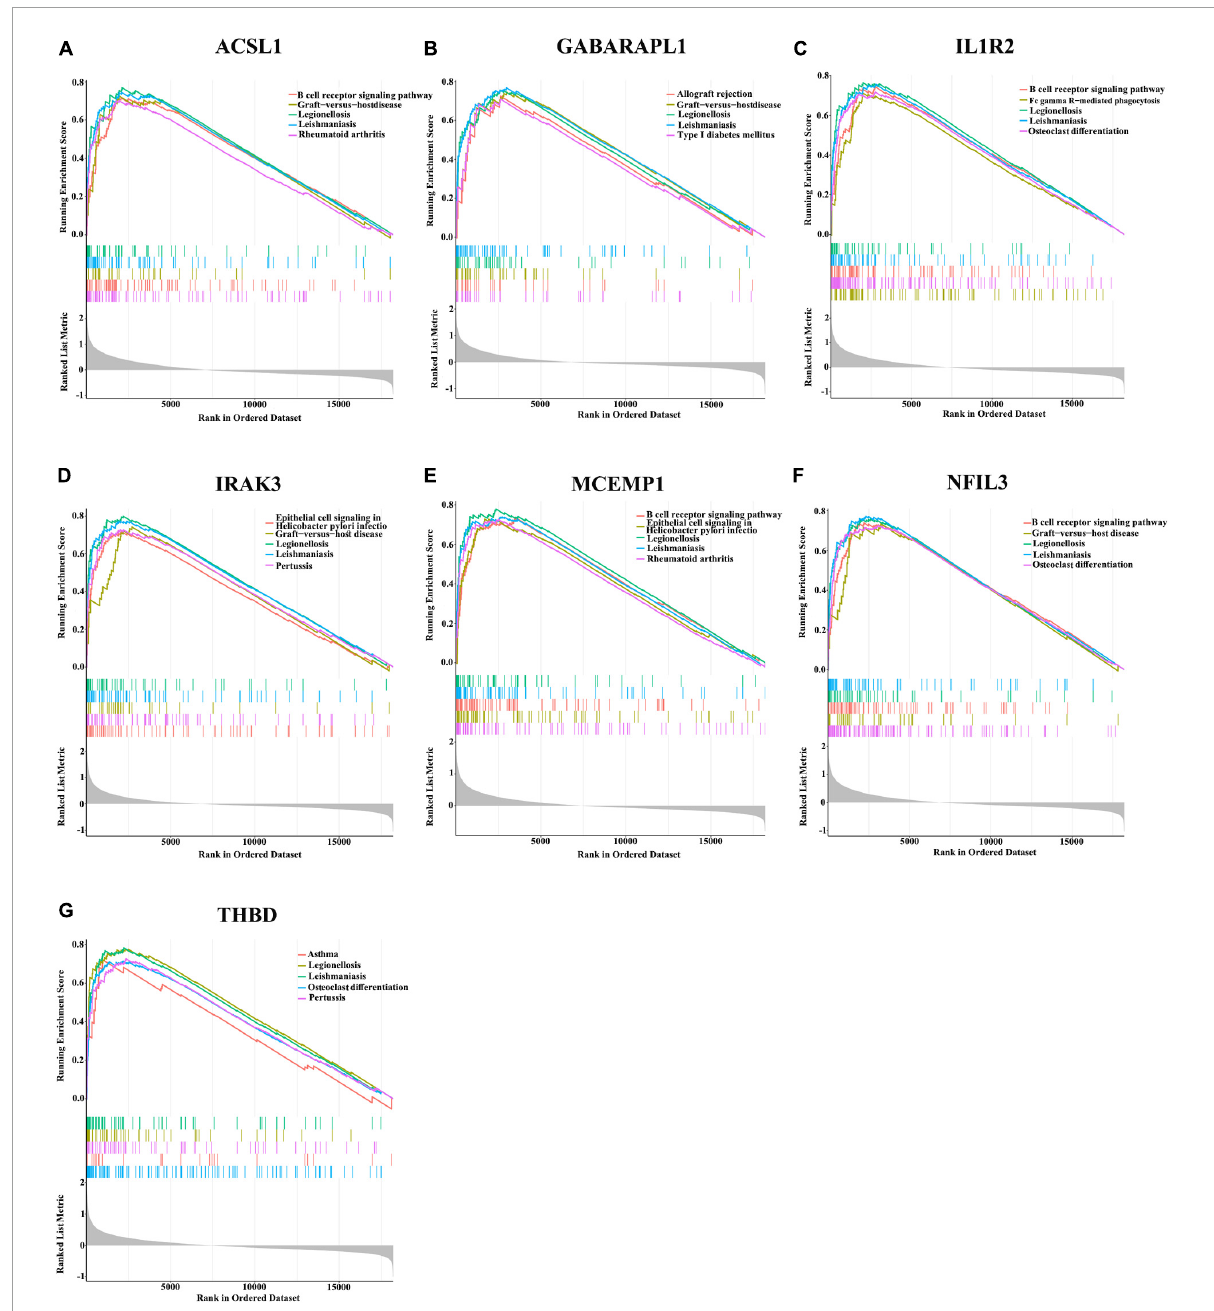
FIGURE8 Gene sets enrichment analysis (GSEA) identifies signaling pathways in the optimal feature genes. (A–G) Top five signaling pathways that are significantly enriched in the high expression of ACSL1 (A) , GABARAPL1 (B) , IL1R2 (C) , IRAK3 (D) , MCEMP1 (E) , NFIL3 (F) , and THBD (G) .